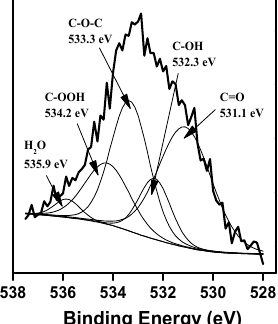
Figure 1. Deconvolution of O 1s spectra of Pd/C catalyst reduced at 300 °C. Catalysts 2018 , 8 , x FOR PEER REVIEW